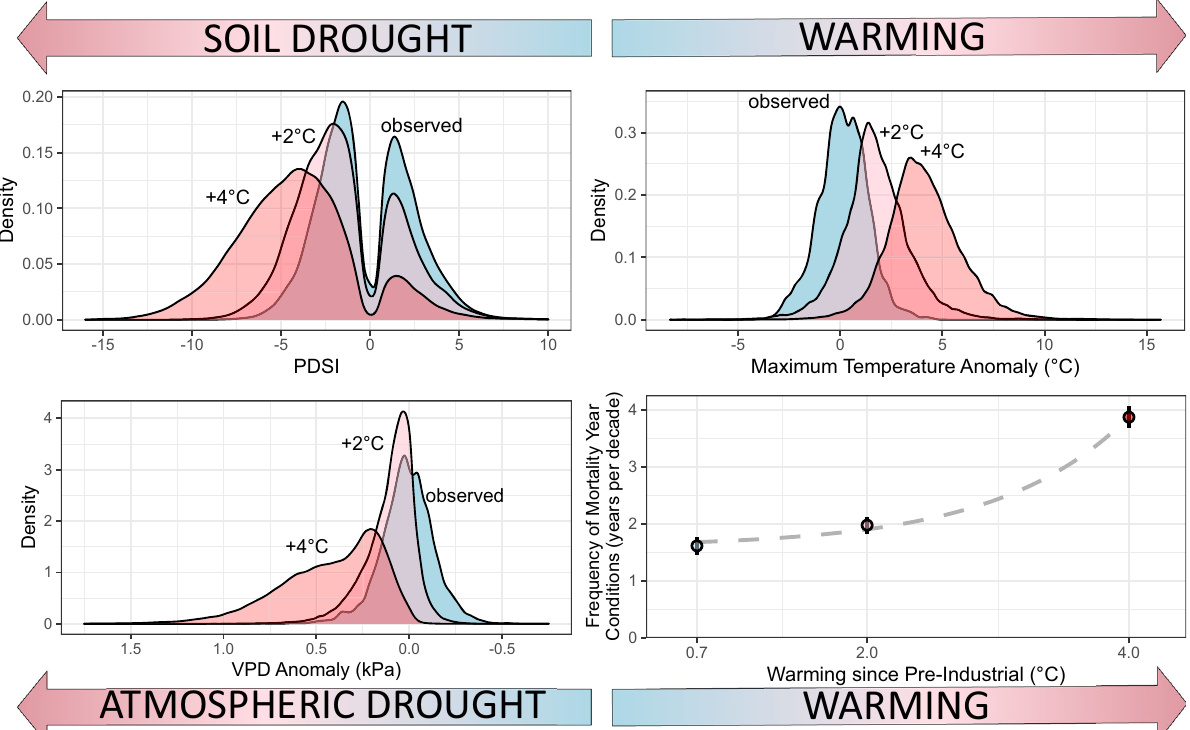
Fig. 6 Warming triple-threat accelerates mortality risks. Under two warming scenarios, leading indicators of tree mortality representing the triple-threat that warming poses to tree survival at the plots in our analysis departed from recent values toward drier (PDSI ( a ), VPD ( c )) and warmer (TMAX values, b ) indicating further warming will shift climatic space toward that recently associated with mortality events. In a – c , the density distributions of PDSI, TMAX, and VPD during observed ( + 0.7 °C, light blue) and warmed + 2 °C (pink) and + 4 °C (red) climate scenarios are shown. In d , open circles show the mean ( n = 675 sites) frequency of mortality year hotter-drought fi ngerprint conditions (when for a particular location, all 6 monthly variables met or exceeded the local hotter-drought fi ngerprint conditions of the mortality year), while the x -axis represents the mean warming since pre-industrial (1850 – 1879) climate. Error bars represent 95% con fi dence interval and the dashed gray line is an exponential fi